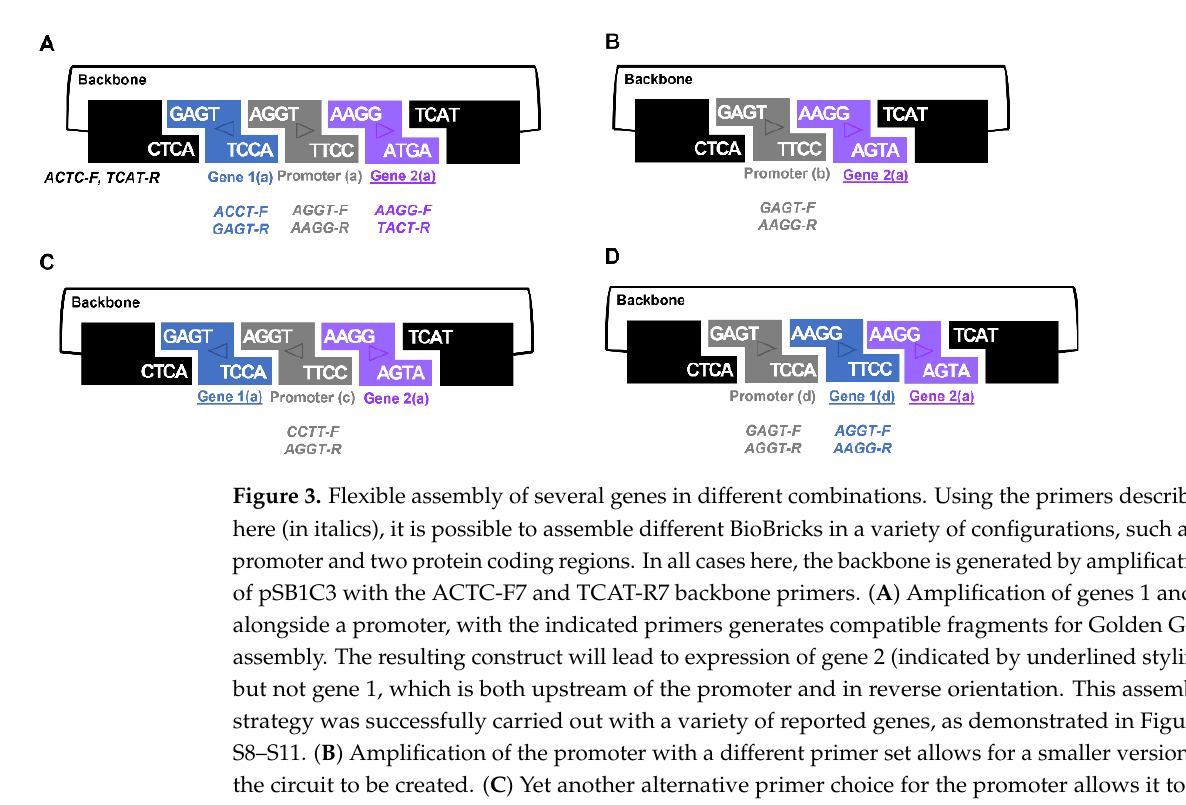
Figure S2: Sequence verification of assembled product; Figure S3: Two-step strategy for Universal Golden Gate amplification; Figure S4: Assembly of a BioBrick in forward and reverse orientation; Figure S5: Flexible assembly of several genes in different orientations; Figure S6: Amplification of selected BioBricks to test for internal or off-target amplification; Figure S7: Proof-reading polymer- ase corrects primer mismatches; Figure S8: Amplification and Sequence Verification using V7 Pri- mers; Figure S9: Sequence verification of amplified backbone; Figure S10: Functional verification of three-fragment assembled products; Figure S11: PCR verification of RFP orientation in three-fragment assembled products; Table S1: Primers used in the Study; Table S2: Primer hybridization motif occur- rence in iGEM distribution kit sequences; Table S3: Primer annealing to select BioBricks as